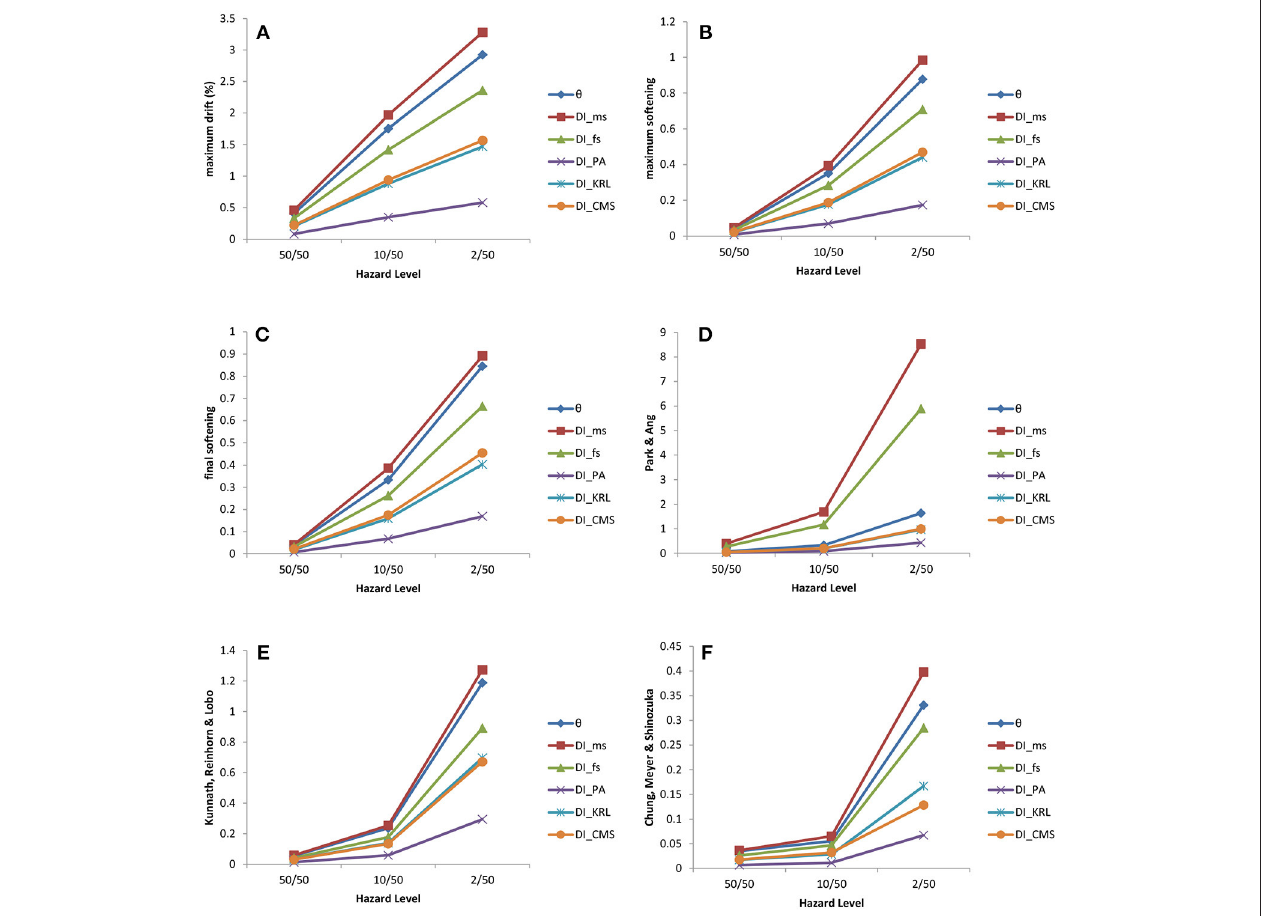
FIGURE 5 | Three-story test example—performances of the optimized designs (i.e., DI θ max , DI ms , DI fs , DI PA , DI KRL , and DI CMS ) for three hazard levels compared with respect (A) maximum drift, (B) maximum softening, (C) final softening, (D) Park and Ang damage index, (E) Kunnath et al. damage index, and (F) Chung et al. damage